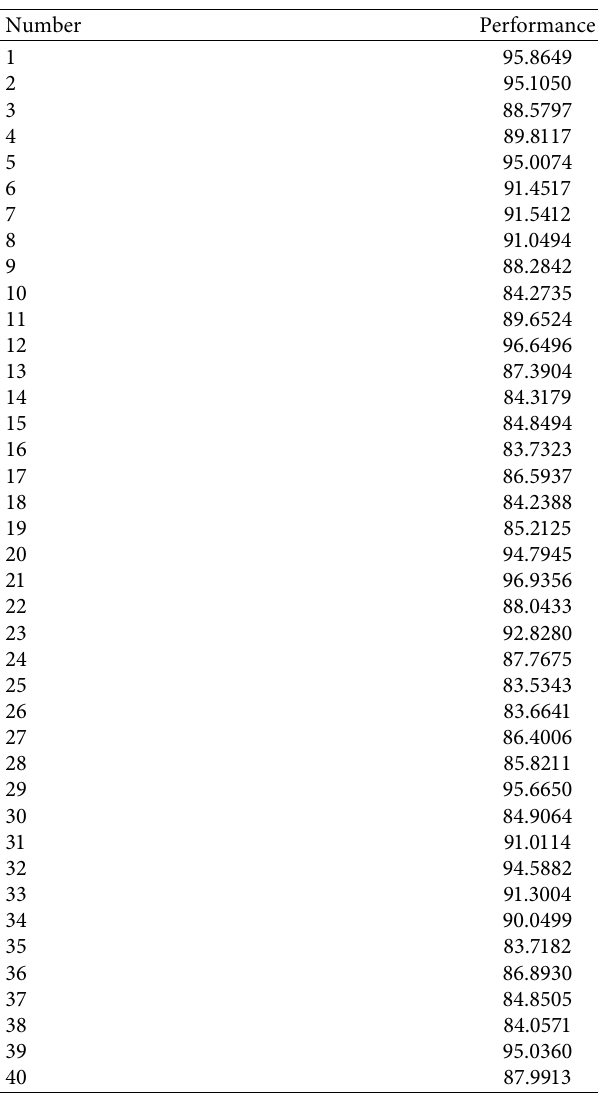
Table 2: Performance evaluation of crop growth monitoring